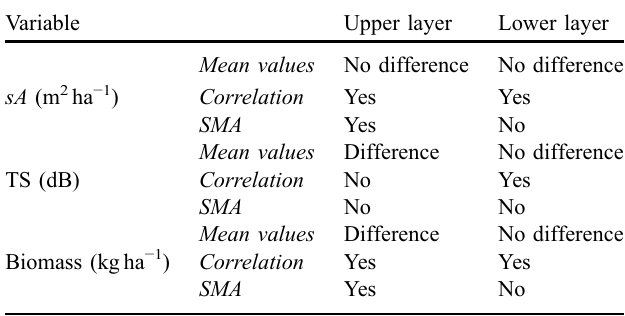
Table 3. Summary of statistical tests ( p < 0.05) comparing results for day-time and night-time surveys. Wilcoxon or Student tests were used to test for differences in means. Pearson or Spearman tests for testing correlations and standardised mean axis (SMA) tests for testing linear relationships (null hypothesis: intercept 0 and slope 1).